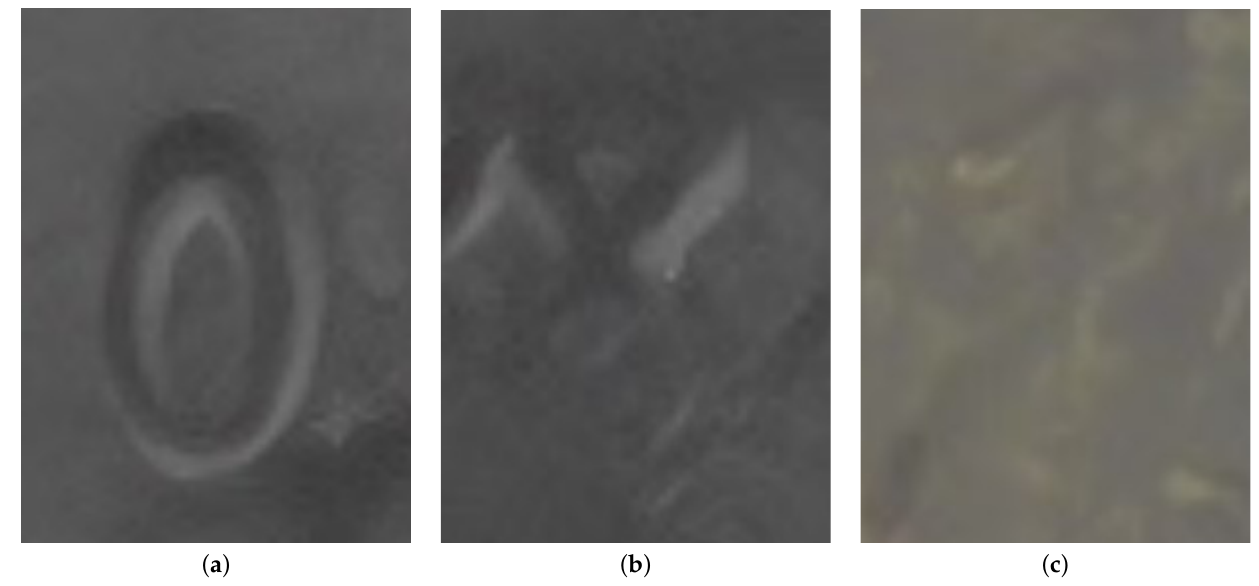
Figure 8. Digits stamped onto a billet surface: well visible ( a ), partially visible ( b ), and poorly visible ( c